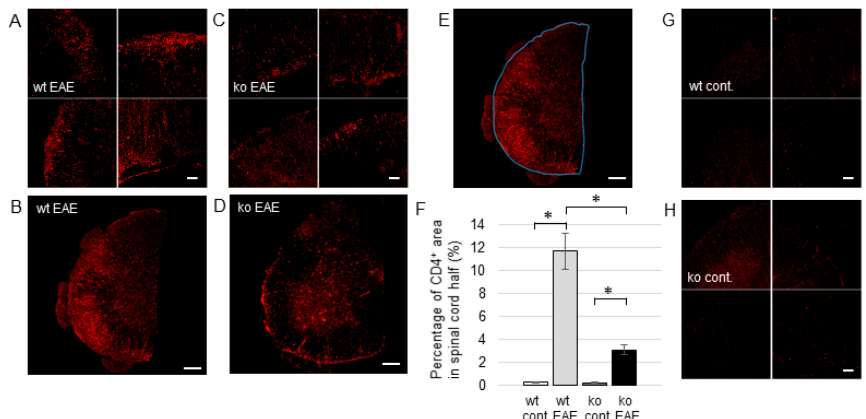
Figure 2. Distribution of CD4 + T cells in EAE spinal cords. Immunohistochemistry image showing CD4 in the inflammatory region of the spinal cord in wt EAE ( A , B ), ko EAE ( C , D ), wt control ( G ), and ko control ( H ) mice. Measurement of half size area in the spinal cord ( E ). Percentage of the CD4 + area in the EAE spinal cord half ( F ). Scale bar (20 μ m) for ( A , C , G , H ), and (200 μ m) for ( B , D , E ). wt, wild-type; ko, mPGES-1 − / − ; cont, naïve mice; EAE, EAE mice. * p < 0.0001.